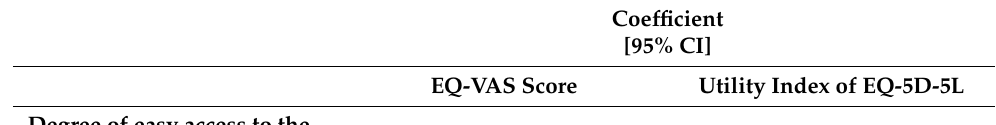
Table 2. Univariate linear regression: by EQ-VAS score and utility index of